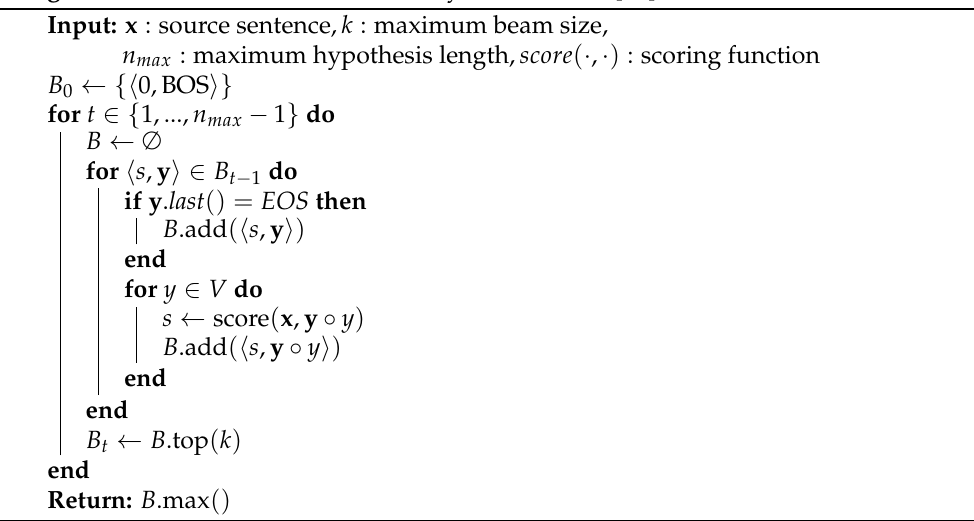
Algorithm 2: Beam search as defined by Meister et al. [57].